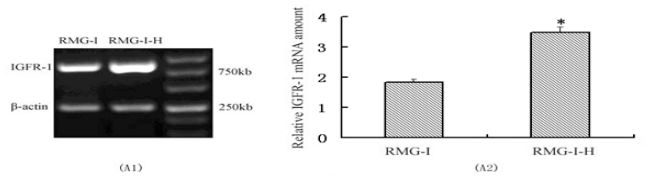
Analysis of IGF-1R after cells transfected with α1,2-FT gene and the expression of IGF-1R of RMG-I-H cell line in control and anti-Lewis(y) monoclonal antibody treated groups (A, B, C, D), and expression of IGF-1R proteins and the Lewis(y) content of the glycans of IGF-1R before and after α1,2-FT gene transfection (E). A1: RT-PCR profiles of IGF-1R in RMG-I and RMG-I-H cell lines. B1: RT-PCR results of mRNA expression of IGF-1R of RMG-I-H cell line in control and anti-Lewis(y) monoclonal antibody treated groups. C1: Western Blot profiles of IGF-1R in RMG-I and RMG-I-H cell lines. D1: Western Blot results of protein expression of IGF-1R of RMG-I-H cell line in control and anti-Lewis(y) monoclonal antibody treated groups. E1: Western blot profiles of immunoprecipitated IGF-1R protein using corresponding antibodies and Lewis(y) antibody. A2, B2, C2, and D2: Relative amount of RT-PCR or Western Blot profiles. E2: Densitometric quantification of IGF-1R ➀ and Lewis(y), ➁ in E1 and calculation of Lewis(y) expression/IGF-1R ➂ (set the RMG-I cells as 100%) (n = 3). * P < 0.01 compared to RMG-I. (IP: Immunoprecipitation by the antibody to IGF-1R; WB: Western immunoblot with the antibodies to IGF-1Ror Lewis(y)). A-E are the representative of three independent and reproducible experiments.